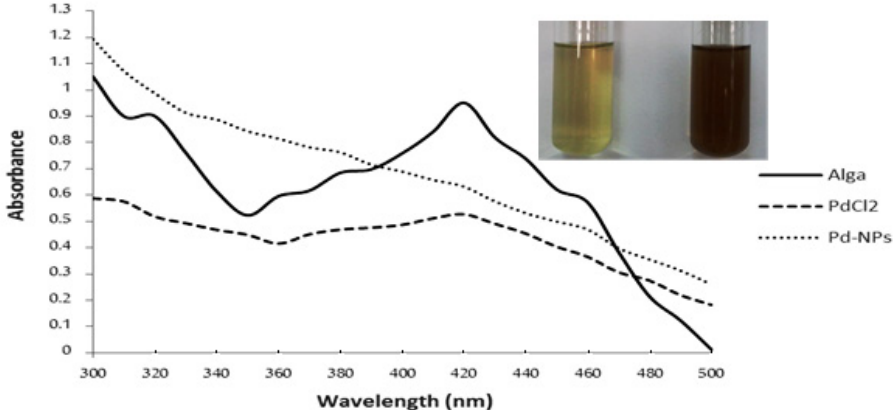
Fig. 1. The UV–Visible spectra of the PdCl solution, alga extract, and palladium oxide Fig.1 the UV–Visible spectra of the PdCl 2 solution, alga extract, and palladium oxide 2 nanoparticles .